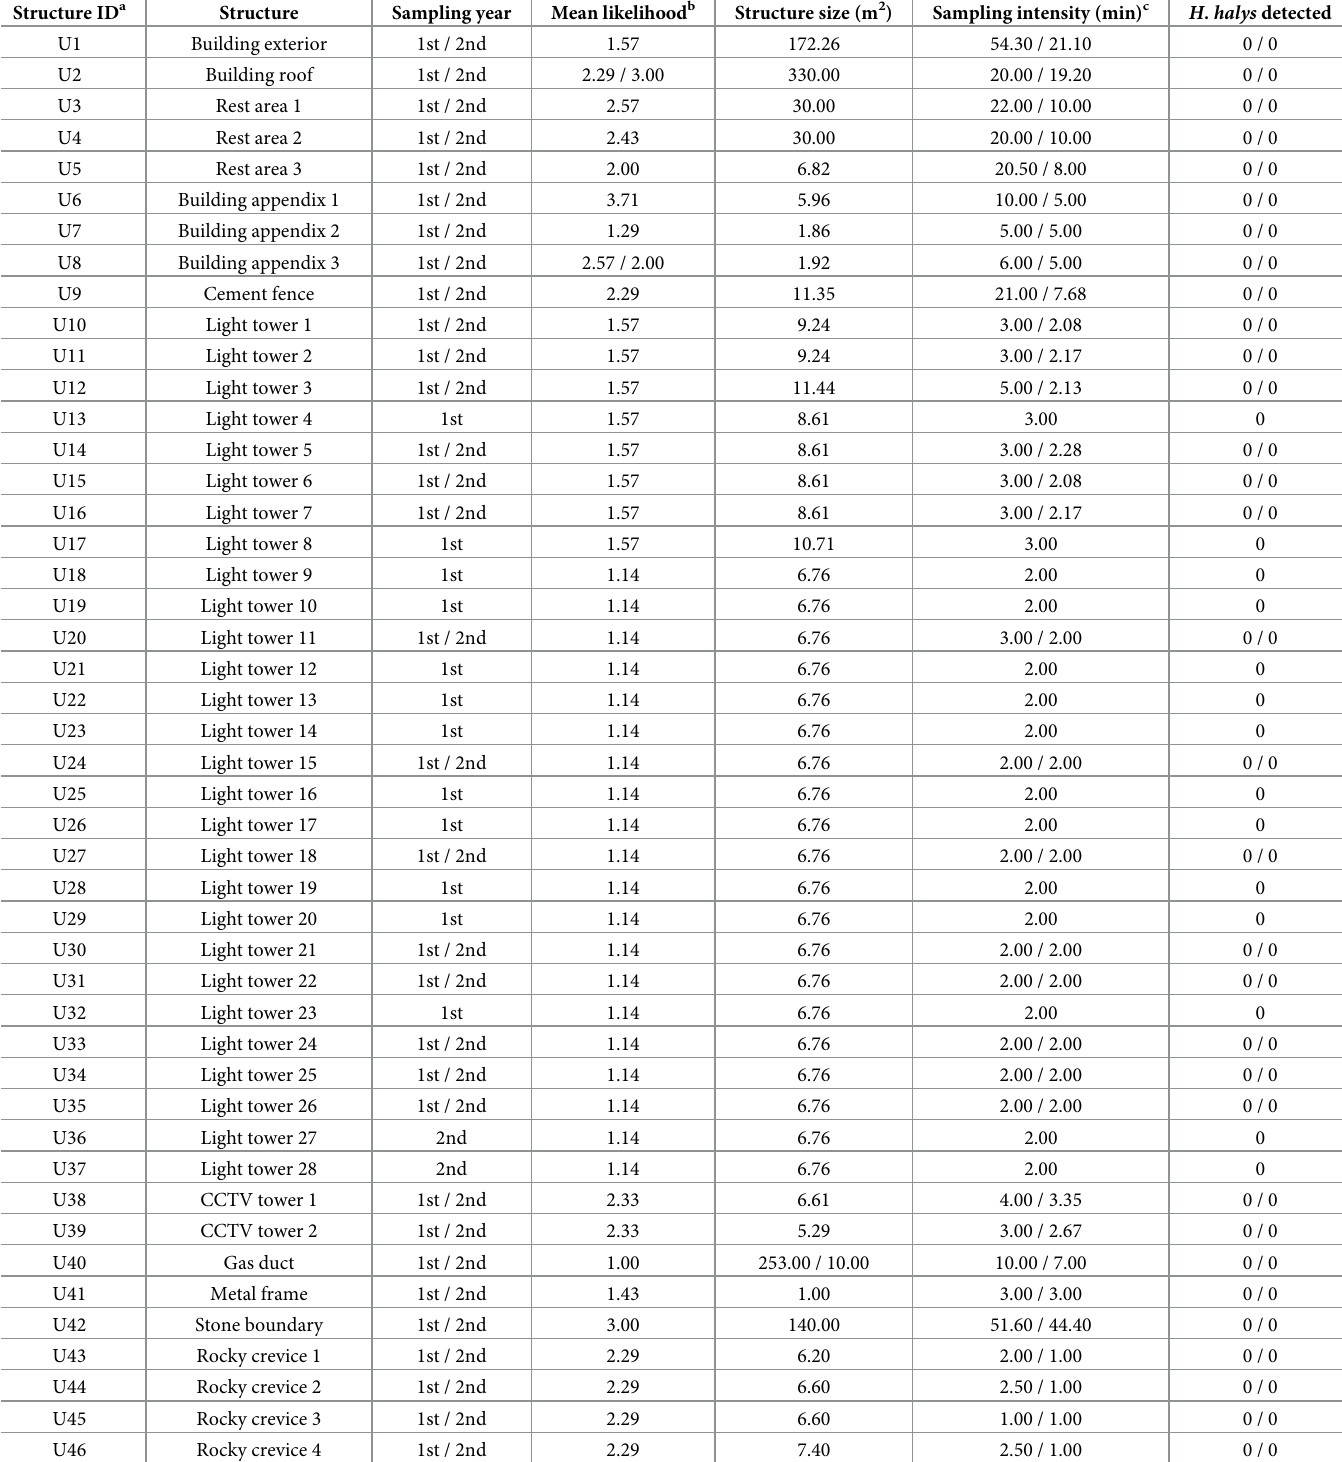
Table 2. Information of structures inspected to detect overwintering Halyomorpha halys in Ulsan and Pyeongtaek ports, Republic of Korea (see Fig 2 for represen- tative photos of inspected structures). Structure ID